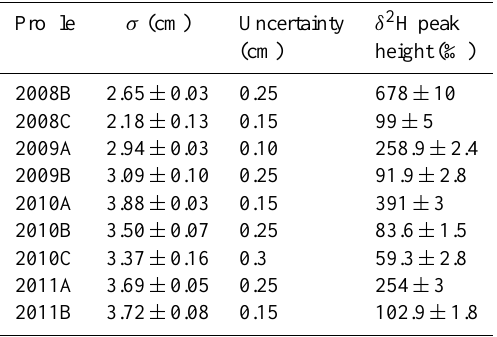
Table 1. The results for the diffusion length σ and for the net peak height for all profiles. The increase of σ as a function of time is clearly visible. The uncertainties in the second column are those from the fitting procedure. The final combined uncertainties in the results are presented in the third column. Except for 2008, all mea- sured values per year agree within their uncertainties. The net peak height is also dependent on the initial thickness of the enriched layer. Therefore the found peak height is variable within and be- tween